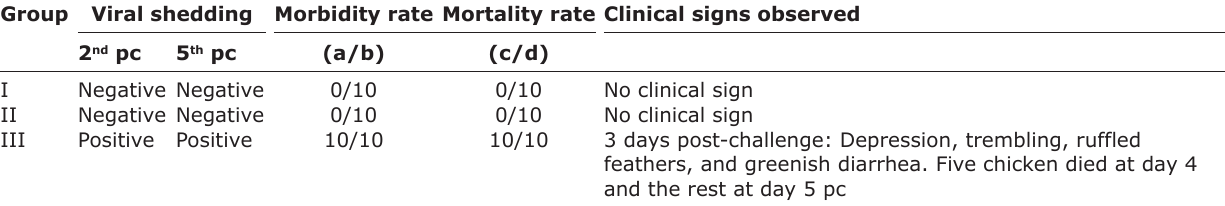
Table-1: Clinical sign, viral shedding, viral re-isolation from dead chicken, and morbidity and mortality rate. Group Viral shedding Morbidity rate Mortality rate Clinical signs observed